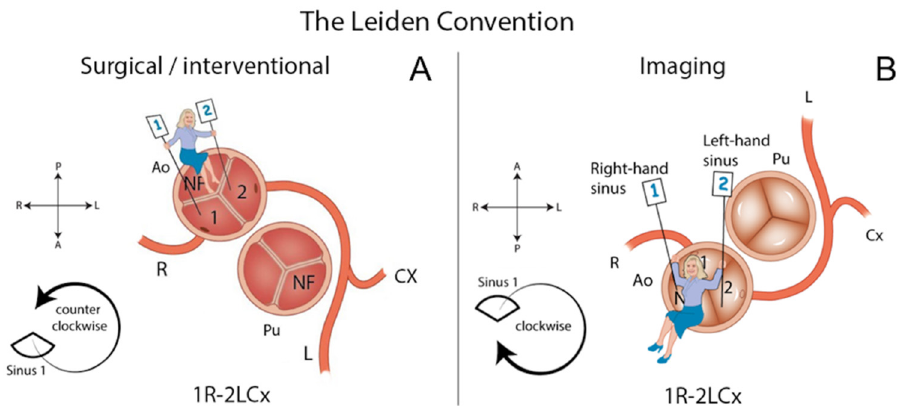
Figure 2. The Leiden Convention considers a surgical/interventional or an imaging perspective (Fig- ure derived with permission from Koppel et al. [5]). ( A ) Surgical/Interventional Leiden Convention. In this method, the coronary anatomy is examined from above, as a surgeon would see it during surgery. The physician sits in the non-facing sinus, facing the pulmonary valve. In that position, the sinus on the right is sinus 1 and the sinus on the left is sinus 2. Starting from sinus 1, the coronary branches are named in the order that they are encountered when following a counterclockwise rota- tion. ( B ) Imaging Leiden Convention. The physician’s view on the coronary anatomy is from the base of the aorta upward. The physician sits in the non-facing sinus of the aortic valve, facing out- ward from the sinus. From this position, the right-hand sinus is again sinus 1, and the left-hand sinus is sinus 2. Following a clockwise rotation , starting at sinus 1, the encountered coronary branches are annotated. A: Anterior. Ao: Aorta. L: Left. NF: Non-facing sinus. P: Posterior. Pu: Pulmonary. R: